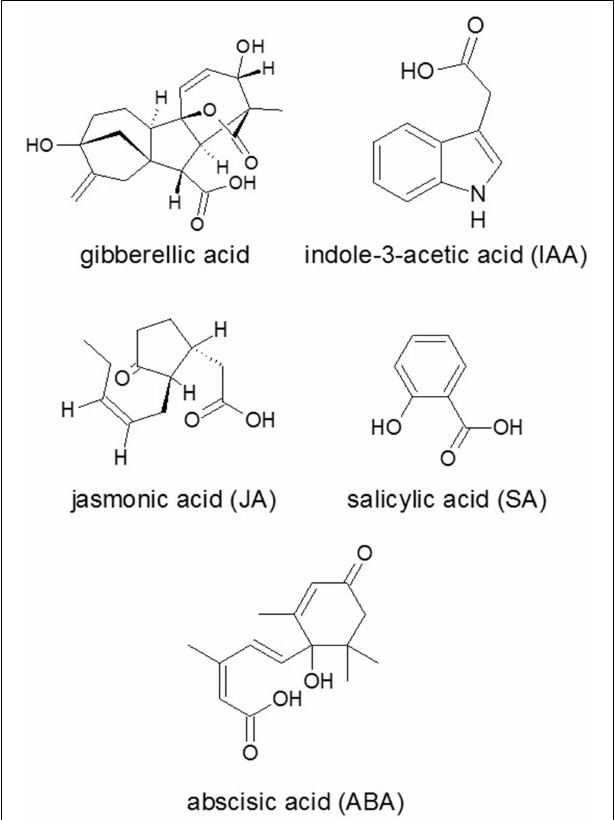
FIGURE 1 | Chemical structures of some plant hormones. Source: National Center for Biotechnology Information. PubChem